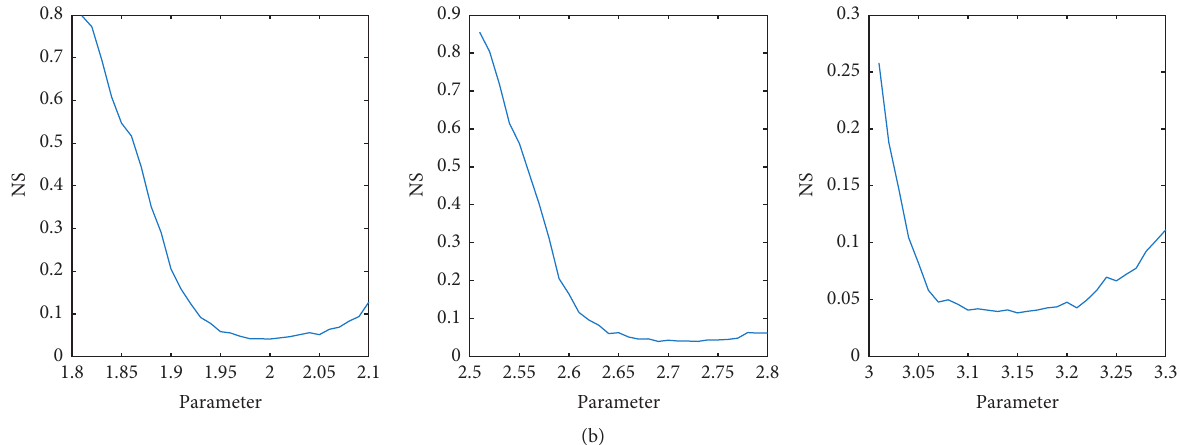
Figure 11: Change of NS with given parameter θ for chaotic noise. The truth values of θ are 2, 2.71, and 3.14 from left to right. All the results are obtained via the average of 200 generated signals. (a) Choatic noise 1. (b) Choatic noise 2. Table 6: Calibration performance with given initial value for chaotic noise. θ